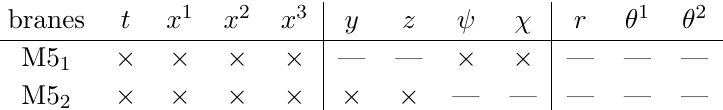
Table 7 . M-theory picture underlying warped N = 2 AdS 5 vacua. This intersection preserves 8 real supercharges and supports a 4d N = 2 SCFT. χ parametrises the M-theory circle.